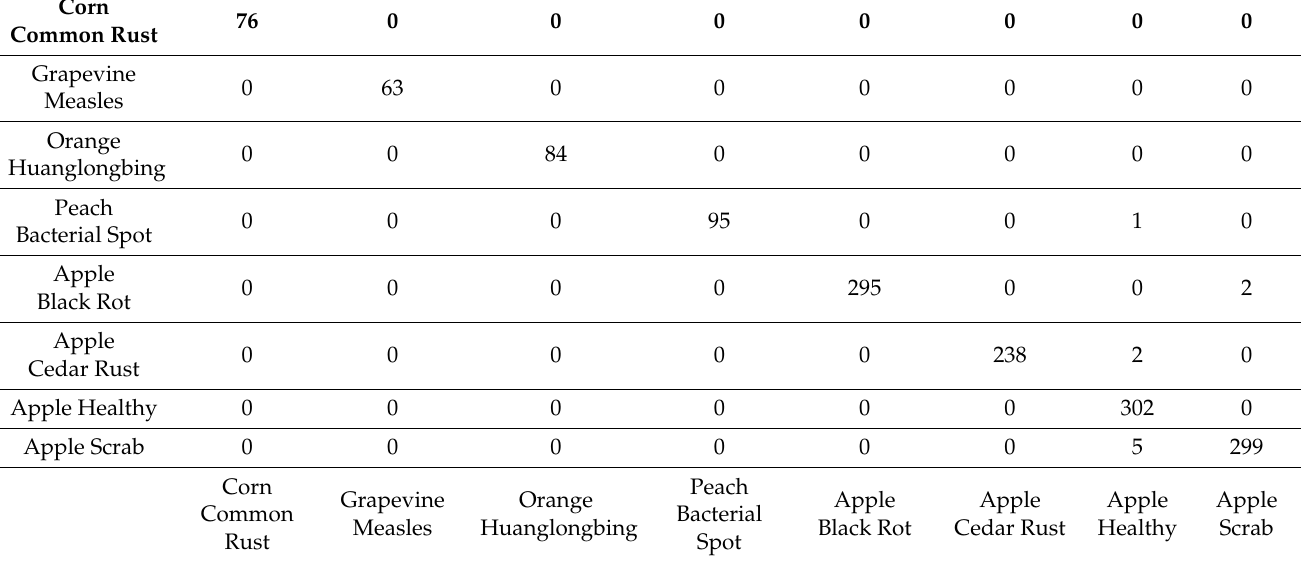
Table 6. Confusion matrix of top 8